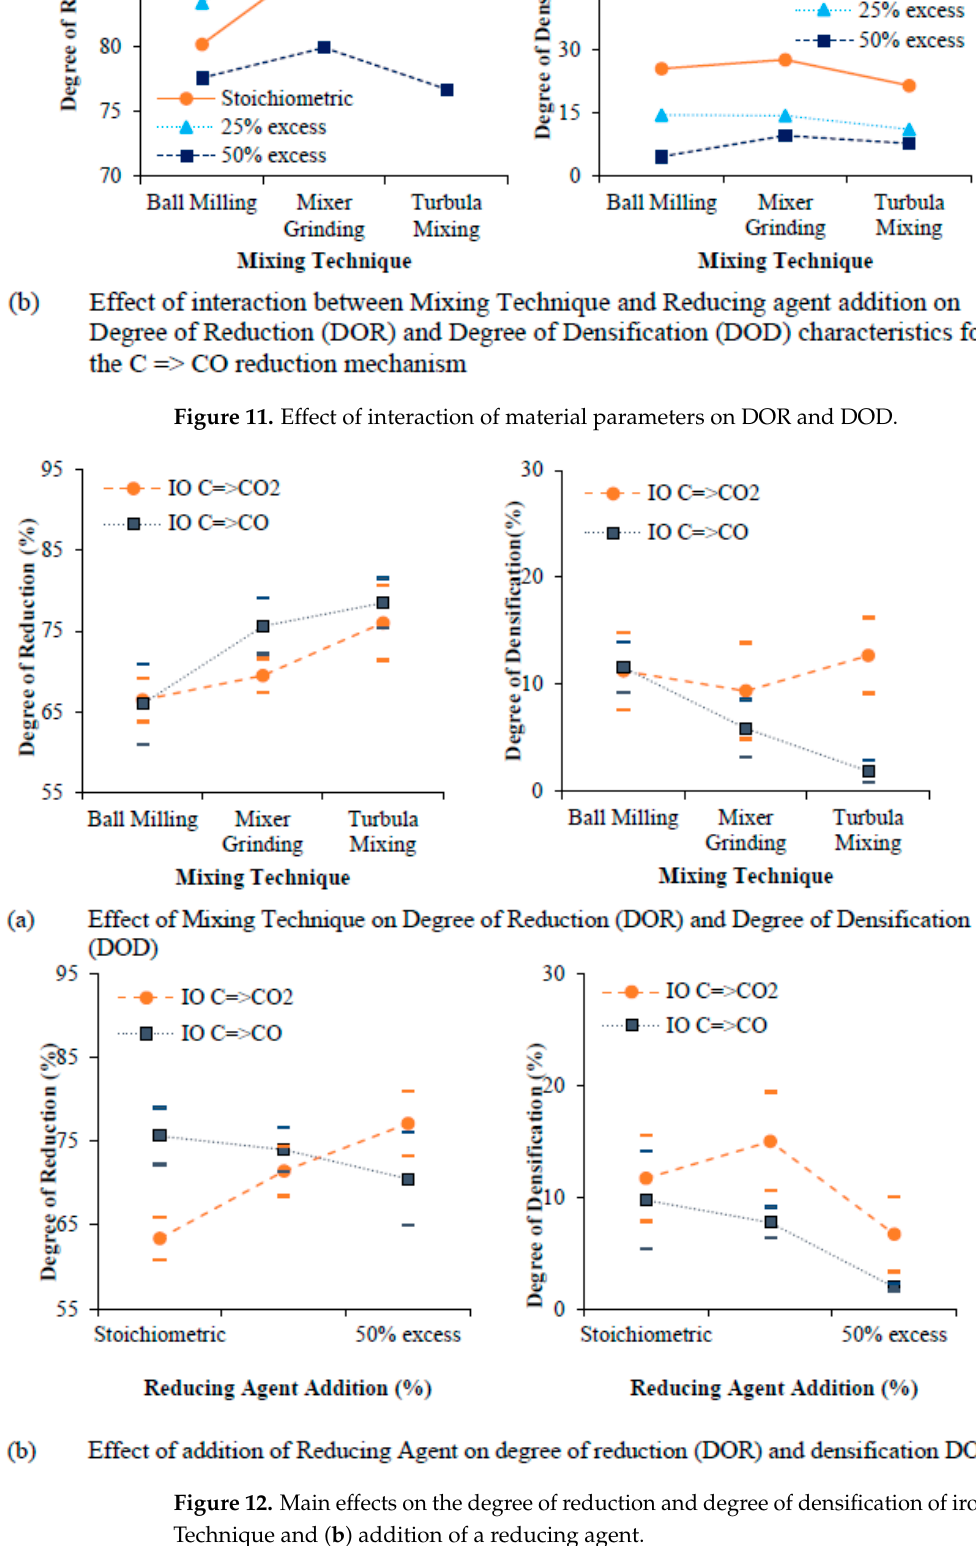
Figure 12. Main effects on the degree of reduction and degree of densification of iron ore of ( a ) mixing Technique and ( b ) addition of a reducing agent. The flow of inert gas (Ar/N 2 ) during sintering also gave a higher degree of reduction (DOR) and degree of densification (DOD) for the study on reduction in iron ore (IO). Upon increasing the temperature of sintering, both the degree of reduction (DOR) and degree of densification (DOD) increased simultaneously, as is shown in Figure 13b. The levels of the reducing agent for facilitating a carbothermic reduction, the reduction in temperature, and the compaction pressure did not considerably change the two quality characteristics (i.e., degree of reduction (DOR) and degree of densification (DOD)). Either graphite or charcoal can be used for enabling carbothermic reduction of iron ore. A reduction in tem- perature to 100 °C below the sintering temperature, or to the same as the sintering tem- perature, is desirable for both the degree of reduction (DOR) and degree of densification (DOD). A compaction pressure of 1050 MPa was chosen for an overall improvement in the two quality characteristics (namely, DOR and DOD).